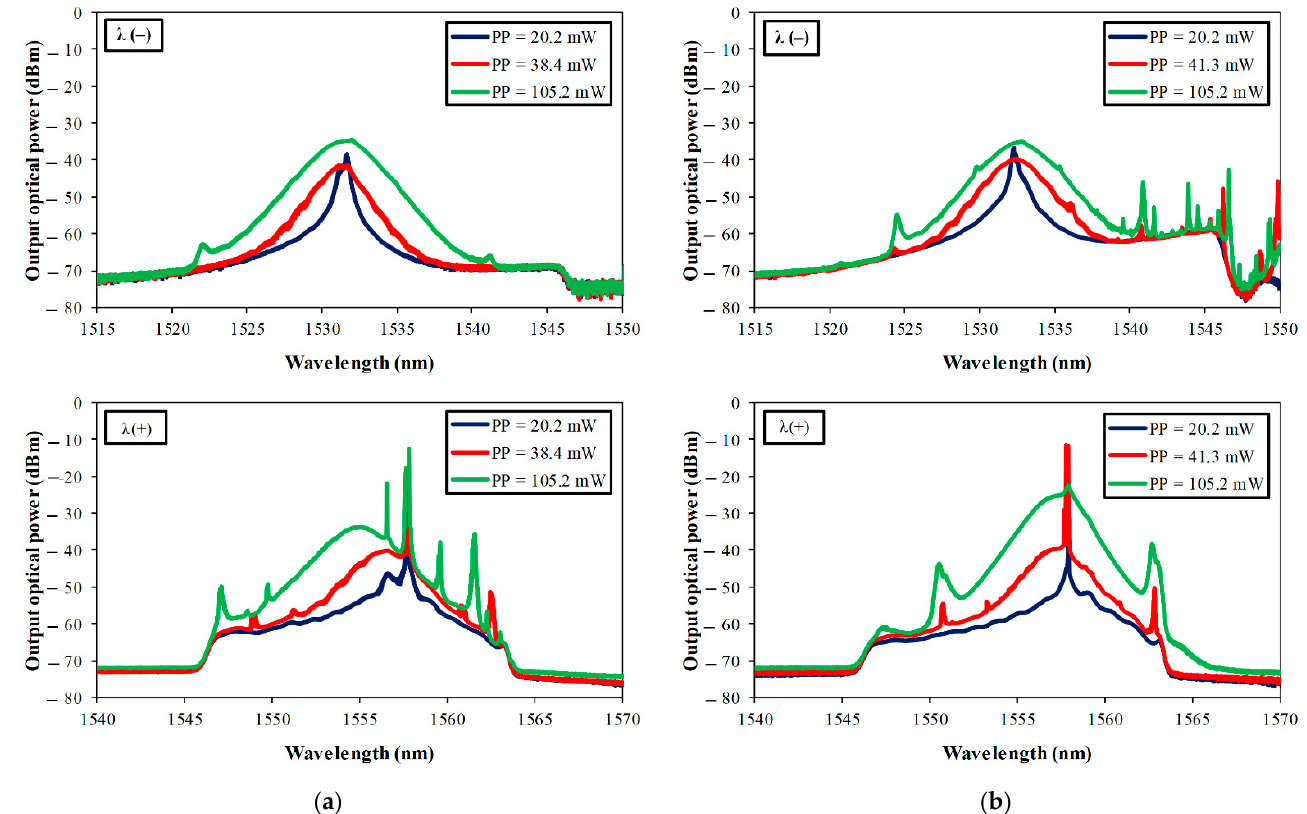
Figure 4. Output spectrum against pump power for ( a ) unidirectional DWML-EDFL and ( b ) bidirectional DWML-EDFL.